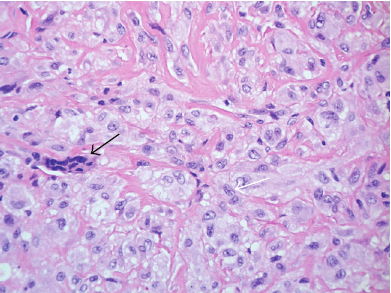
Figure 2: H&E staining of sclerosing epithelioid fibrosarcoma after treatment with neoadjuvant chemotherapy (magnification × 400). The tumor is composed of few scattered polynuclear giant cells (black arrow) and groups of cells, which are rich in cytoplasm and show pale, vesicular, and irregular nuclei without any substantial mitotic activity (white arrow). The tumor cells are embedded in a collagen-rich extracellular matrix and display no signs of